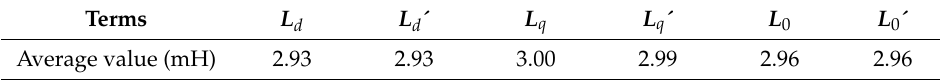
Table 7. Average values of d - and q - inductance based on different